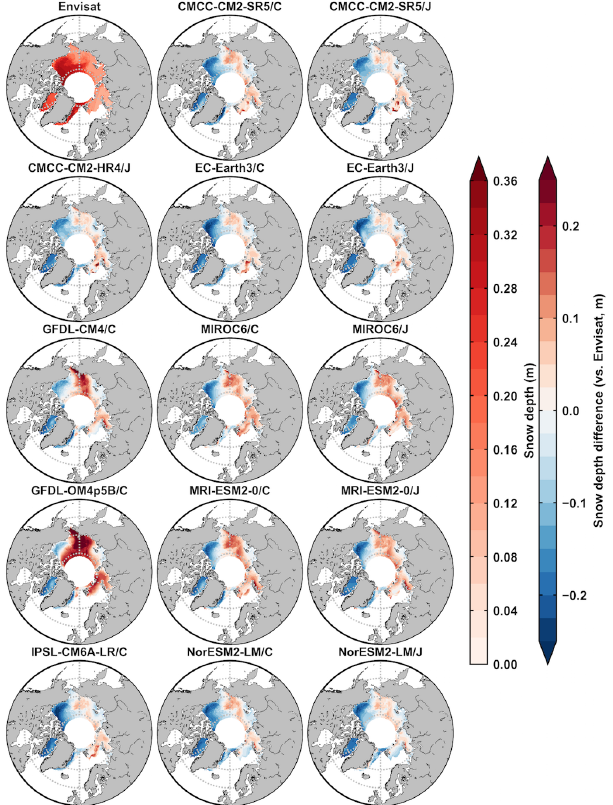
Figure A8. The 2003–2007 September mean Antarctic snow depth from Envisat data (first picture, m) and snow depth differences between model outputs and Envisat data (m). The second and third columns are from the five OMIP1 and OMIP2 model out- puts of CMCC-CM2-SR5, EC-Earth3, MIROC6, MRI-ESM2-0, and NorESM2-LM,